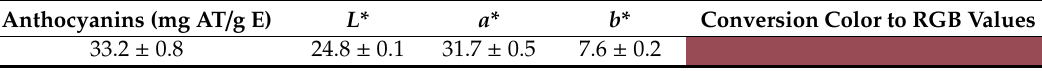
Table 3. Quantification of anthocyanin compounds in the extract and color evaluation (CIE L *, a *, b *). Anthocyanins (mg AT / g E) L * a * b